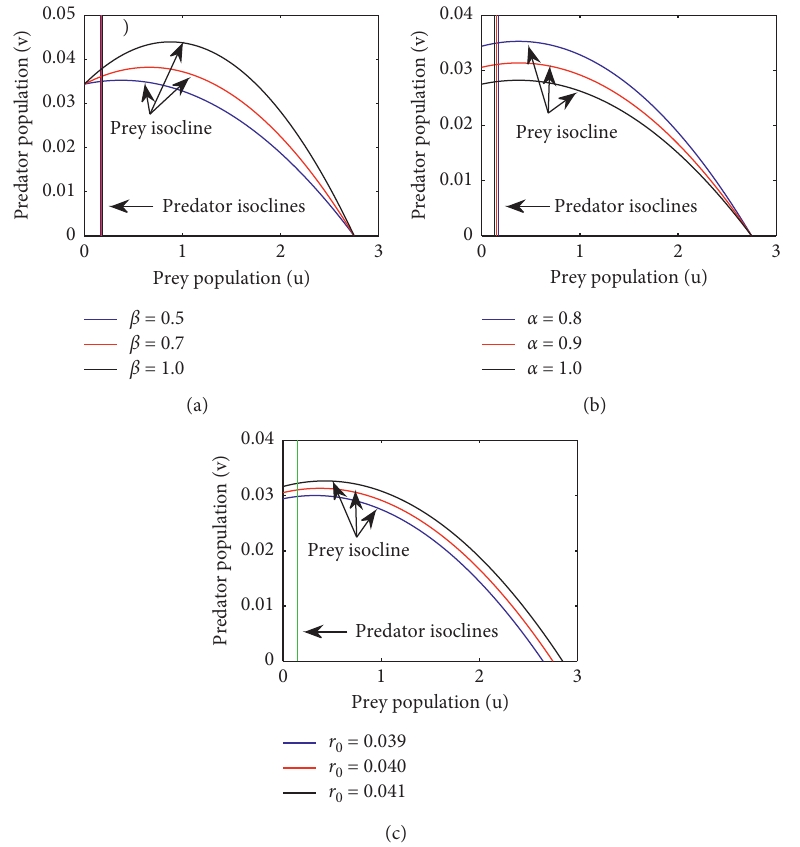
Figure 1: Isoclines of the predator-prey system (4) for three different cases with the following set of parameter values: � 0 . 04 , δ � 0 . 0125 , c � 0 . 01 , α � 0 . 8 , β � 0 . 5 , θ � 0 . 4, and δ r 0 1 shown in the